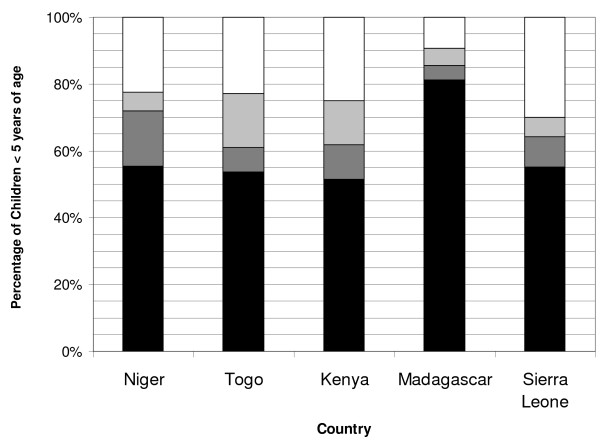
Percentage of all children <5 years of age in each of the four ITN use categories, in Niger, Togo, Kenya, Madagascar, and Sierra Leone during the rainy season. Denominator includes all children <5 years of age. ITN use categories are: white: living in households with no ITN present; light grey: living in households owning but not hanging an ITN; dark grey: living in households that have an ITN hanging but are not sleeping under an ITN; and black: sleeping under an ITN.